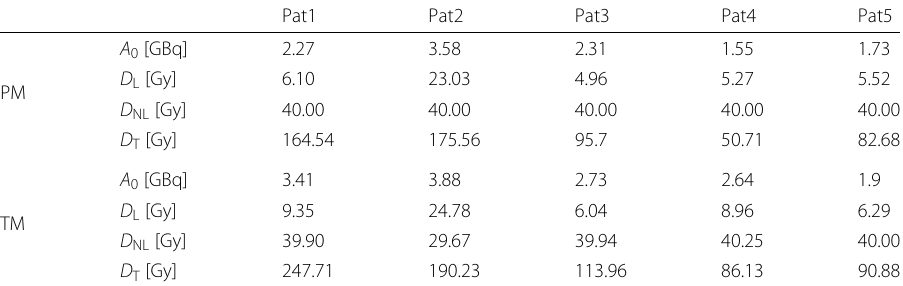
Table 4 Activity and dose calculation were performed for five patients according to TM and the classical PM Pat1 Pat2 Pat3 Pat4 Pat5 A 0 [GBq] 2.27 3.58 2.31 1.55 1.73 D L [Gy] 6.10 23.03 4.96 5.27 5.52 PM D NL [Gy] 40.00 40.00 40.00 40.00 40.00 D T [Gy] 164.54 175.56 95.7 A 0 TM